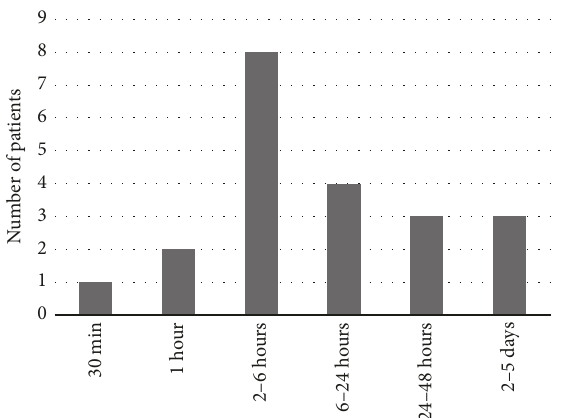
Figure 2: Period of time between water absorbent bead ingestion and referral to the